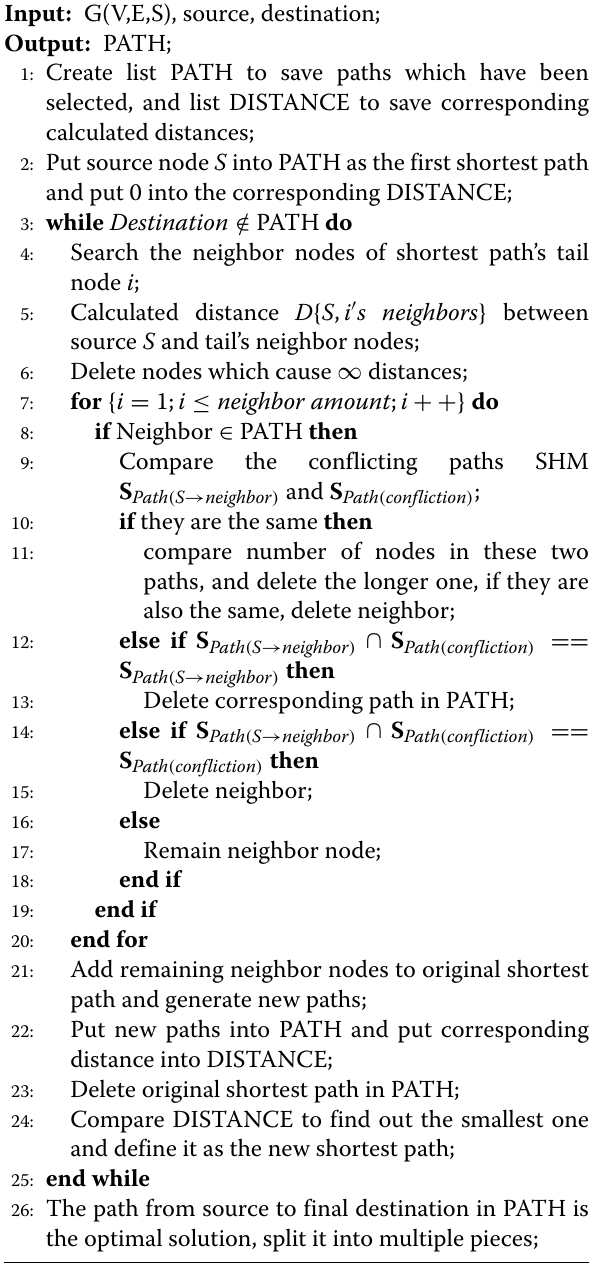
Algorithm 2 Optimal path selection